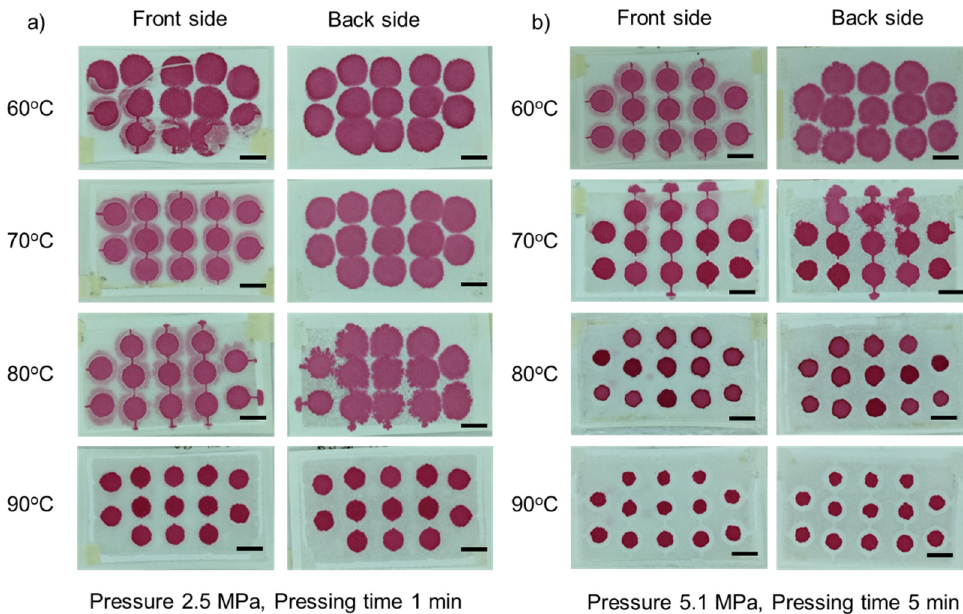
Figure 3. Effect of temperature: ( a ) under a pressure of 2.5 MPa and 1 min pressing time; ( b ) under a pressure of 5.1 MPa and 5 min of pressing time. The temperature was varied from 60 to 90 °C (left column shows the front side, right column shows the back side). Scale bar is 5 mm.